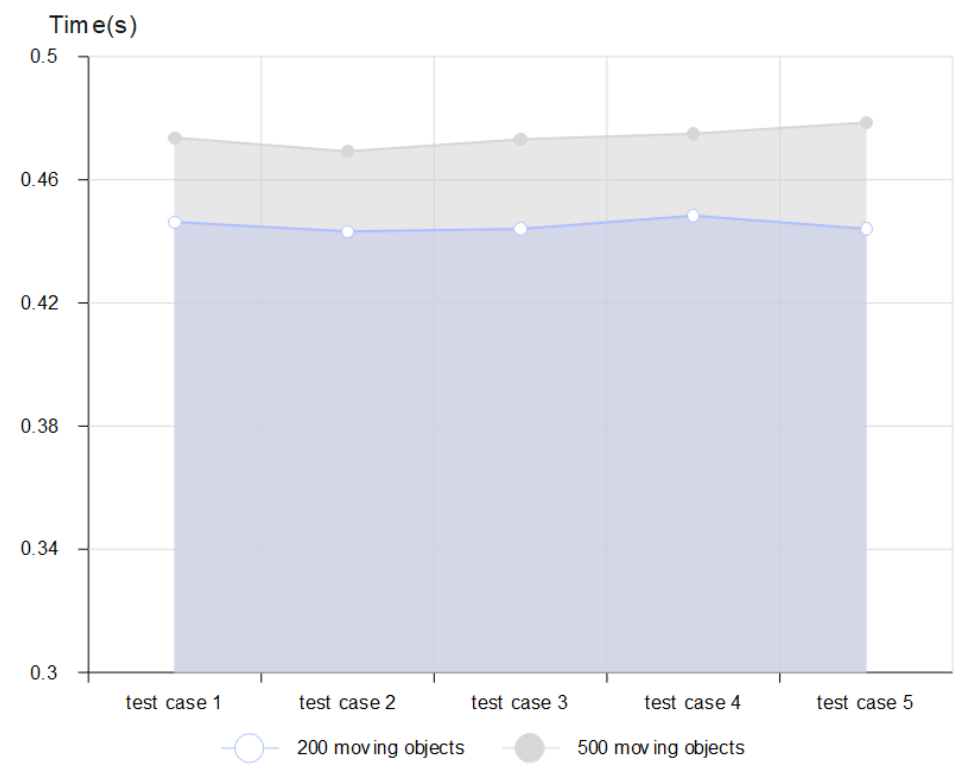
Figure 10. Random test cases (200 and 500 moving